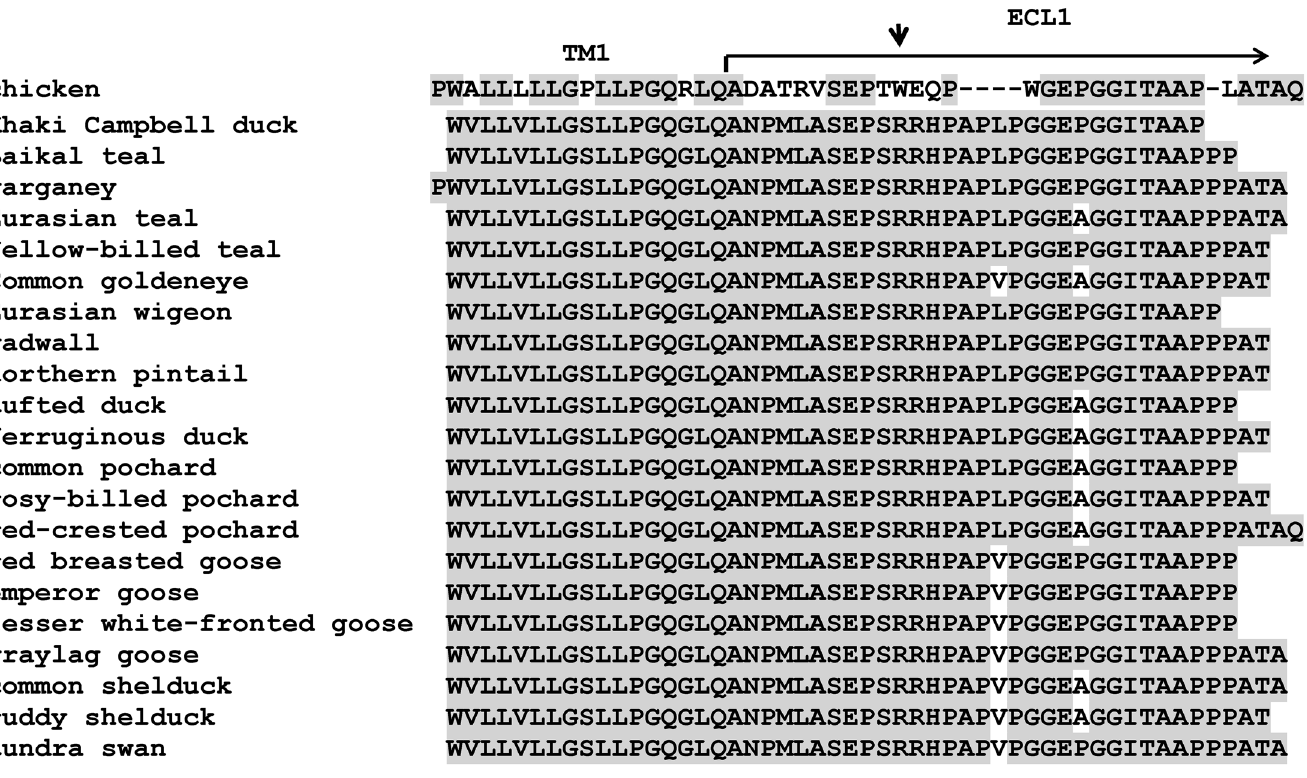
PLOS ONE | DOI:10.1371/journal.pone.0150589 March 15,